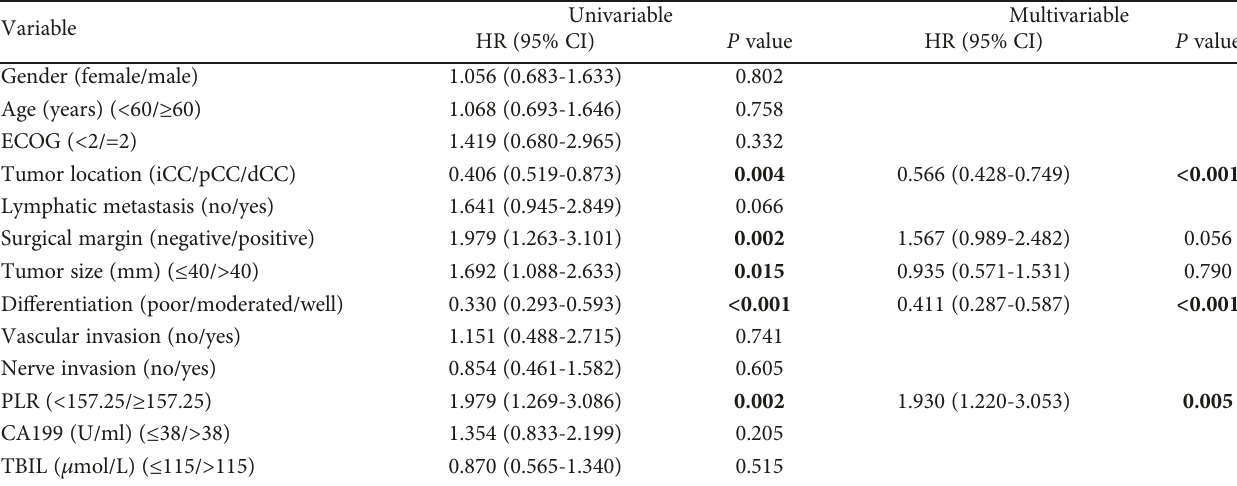
Abbreviations: PLR: platelet-lymphocyte ratio; ECOG: Eastern Cooperative Oncology Group; iCC: intrahepatic cholangiocarcinoma; pCC: perihilar cholangiocarcinoma; dCC: distal cholangiocarcinoma; CA199: carbohydrate antigen 19-9; TBIL: total bilirubin; HR: hazard ratio; CI: con fi dence; P < 0 05 was considered signi fi